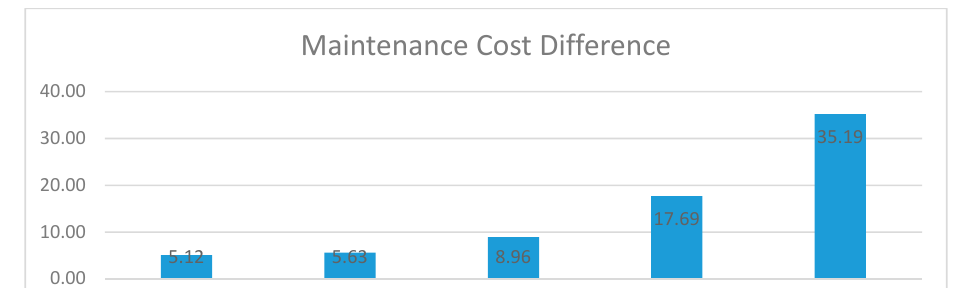
Figure 9. Maintenance cost of the systems.